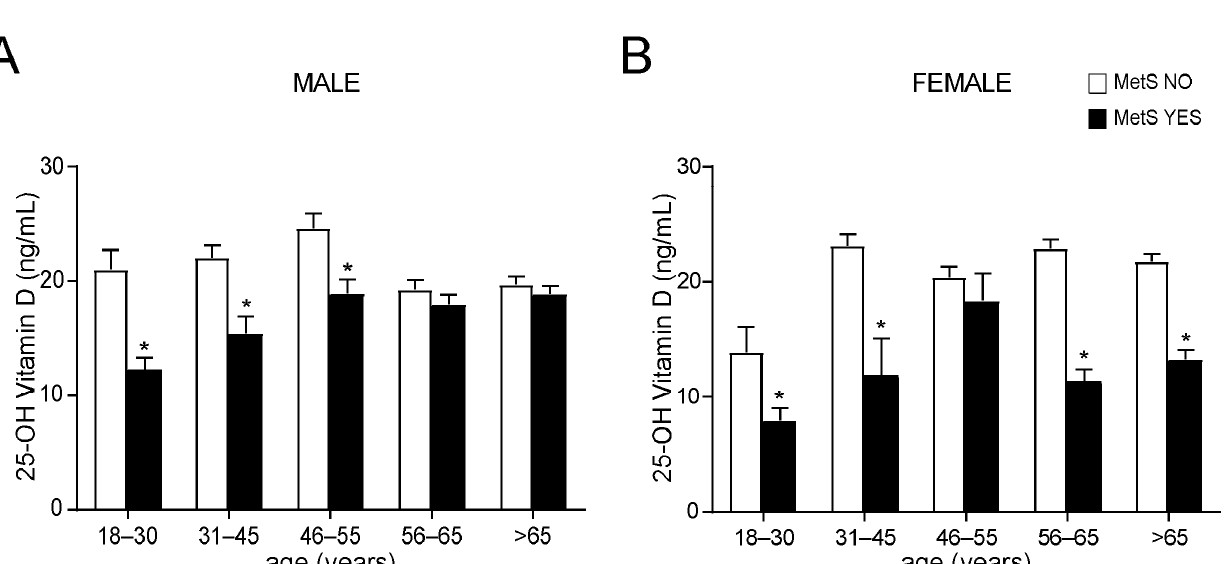
Figure 3. Comparison of OH-25 vitamin D levels in non-metabolic and metabolic subjects, divided by gender and age. ( A ) Comparison of OH-25 vitamin D levels in male subjects. Patients were classified in non-metabolic (MetS NO) and metabolic (MetS YES) subjects and divided by age ranges. Data is presented as mean ± SEM. Statistical significance was assessed by Student T-test (* p < 0.05). ( B ) Comparison of OH-25 vitamin D levels in female subjects according to the MetS definition (IDF). Patients were divided by age ranges. Data is presented as mean ± SEM. Statistical significance was assessed by Student t -test (* p < 0.05).